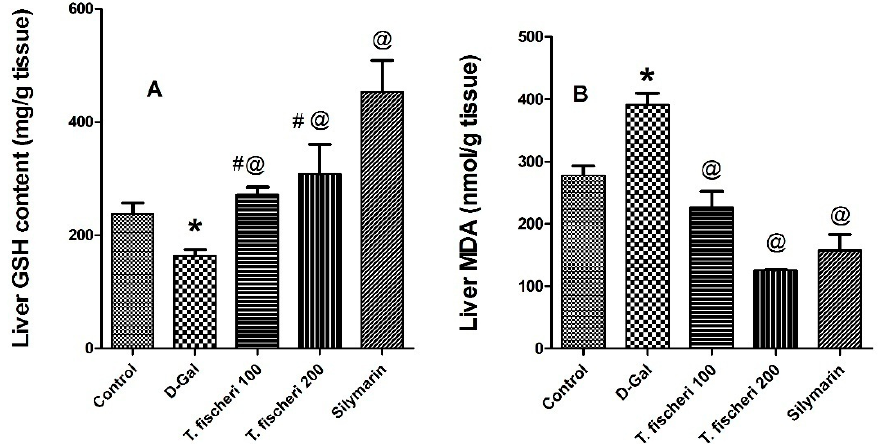
Figure 10. Influence of a single oral dose of D-galactosamine-induced liver injury (800 mg/kg) and oral administration of two doses (100 mg/kg and 200 mg/kg b.w.) of T. fischeri extract and the positive control silymarin (100 mg/kg) on ( A ) Reduced glutathione content (GSH, mg/g liver tissue); ( B ) Malondialdehyde content (MDA, nmol/g liver tissue). Results are expressed as mean ± SEM. * Significant difference compared to normal control group; @ Significant difference when compared to D-GalN treated group at p < 0.05; # significant difference compared to silymarin treated group at p < 0.05, n = 6; by One Way ANOVA and Tukey post hoc test.